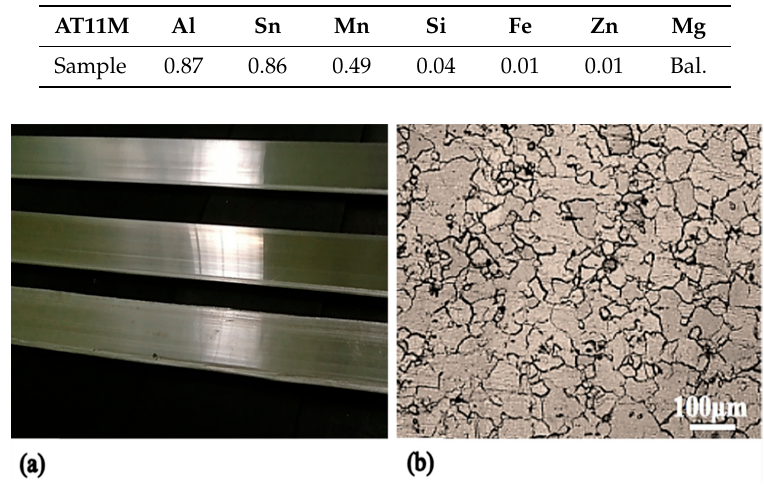
Table 1. Chemical composition of the AT11M alloy (wt %).